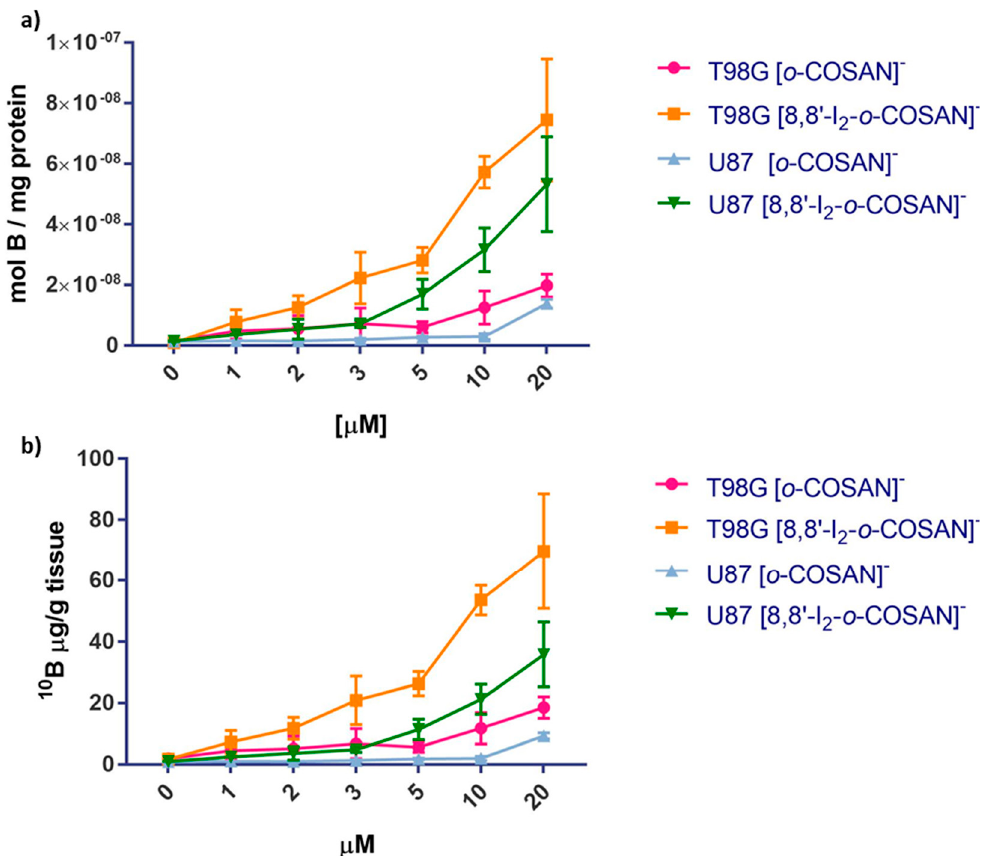
Figure 10. Upload of boron in U87 and T98G cells incubated in the presence of increasing concentration of [ o- COSAN] − and [I 2 - o -COSAN] − for 24 h at 37 ◦ C expressed as mol B/mg of protein ( a ) and µ g 10 B/g tissue ( b ). Error bars indicate the SD.